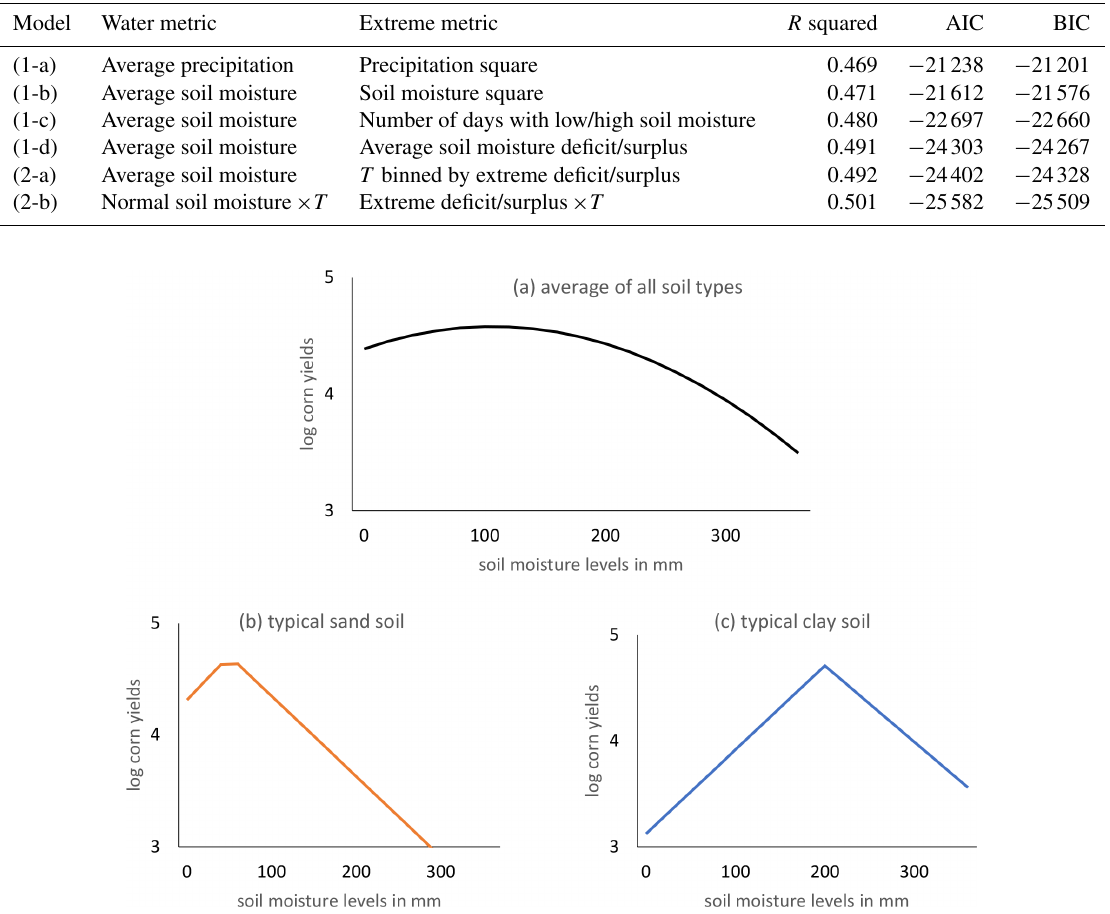
Figure 6. Estimated impact of soil moisture on log corn yields. Including soil moisture in the regression and its square term, as in Model (1-b), will give us a quadratic relationship between soil moisture and yields, as seen in (a) . A piecewise linear parametrization, as in Model (1-d), can provide the location-specific piecewise linear relationship based on soil moisture deviation from normal, as seen in (b) and (c) . This will cause the maximum of the response curve to be in lower soil moisture levels for sand and in higher soil moisture levels for clay soil